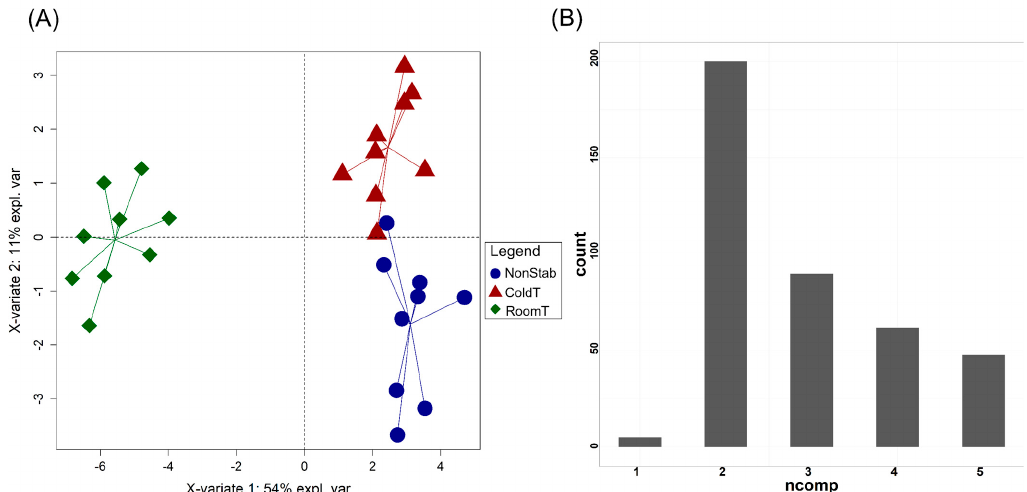
Figure 3. Graphical outputs of the multilevel partial least squares discriminant analysis (ML-PLS- DA) carried out to discriminate between the brandy samples before and after cold stabilization and filtration. ( A ) Scores plot for component 1 (X-variate 1) and component 2 (X-variate 2), and ( B ) histogram of the number of components optimized for the sub-models during the double-cross validation. NonStab: non-stabilized brandies; ColdT: brandy stabilized at cold temperature; RoomT: brandy stabilized at room temperature. The model was optimized and validated following a double cross-validation scheme.